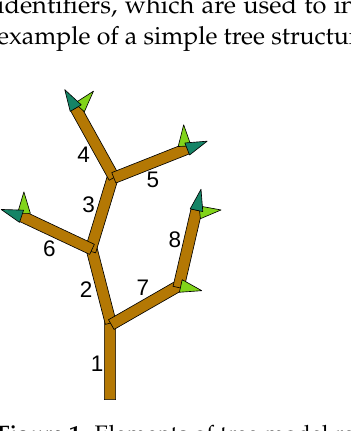
Figure 1. Elements of tree model representation: internodes (brown), terminal buds (dark green), and lateral buds (light green). Depth-first ordering is used to assign unique identifiers to